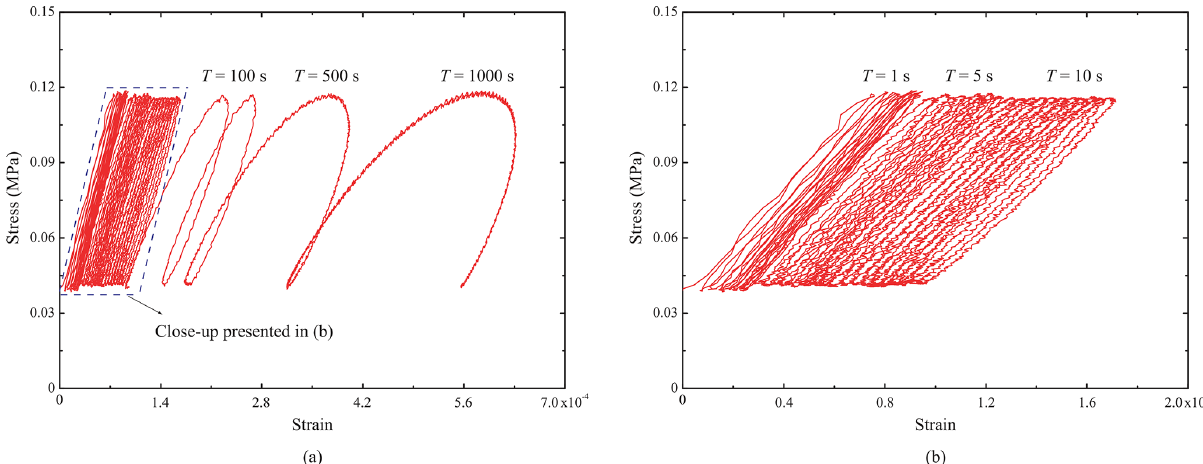
Figure 11. Stress–strain plots of specimen Floating-5ppt-1 tested with stresses varying from 0.04 to 0.12MPa and with an average temper- ature of − 2 . 5 ◦ C: (a) shows the response for all periods, T , of cyclic loading, while (b) presents a close-up showing the cycles for T = 1, 5 and 10s.